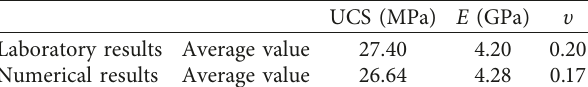
Table 2: Comparison of the simulation model and the results of the laboratory model.